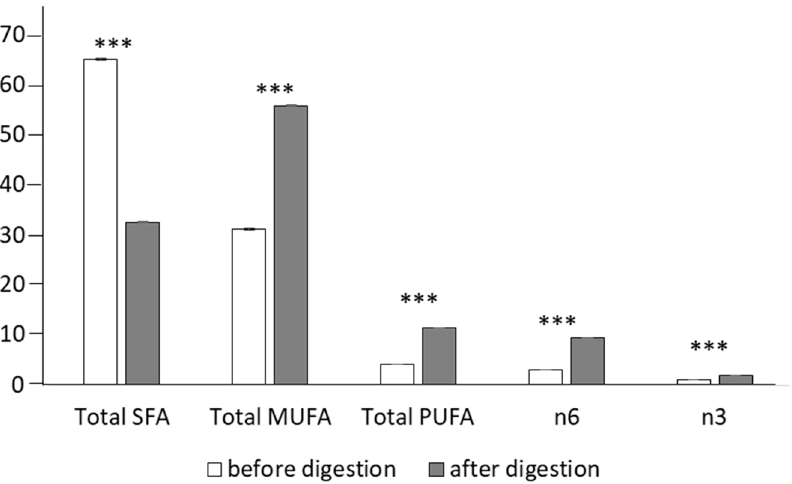
Figure 5. Fatty acid indexes before and after the in vitro digestion of the whey-beverage; SFA: saturated fatty acids; MUFA: monounsaturated fatty acids; PUFA: polyunsaturated fatty acids. Asteriscs means significant differences (one-way ANOVA and LSD test, *** p < 0.001). Before digestion, the major FA of the Colada was palmitic acid (C16:0, 32%), followed by oleic (C18.1n9, 28%) and stearic acid (C18:0, 17%); this is in agreement with the main FA observed in whey [55] and in milk fat [56]. Total SFA represented the major fraction of the undigested sample (65%), whereas MUFA and PUFA contributed 31 and 4%,